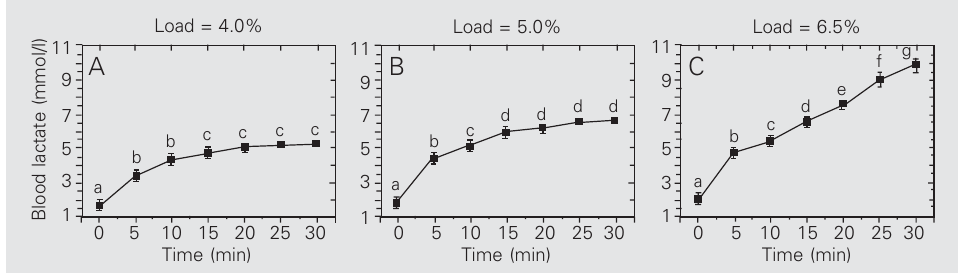
(min)Load = 4.0% Load = 5.0% Load = ood B l